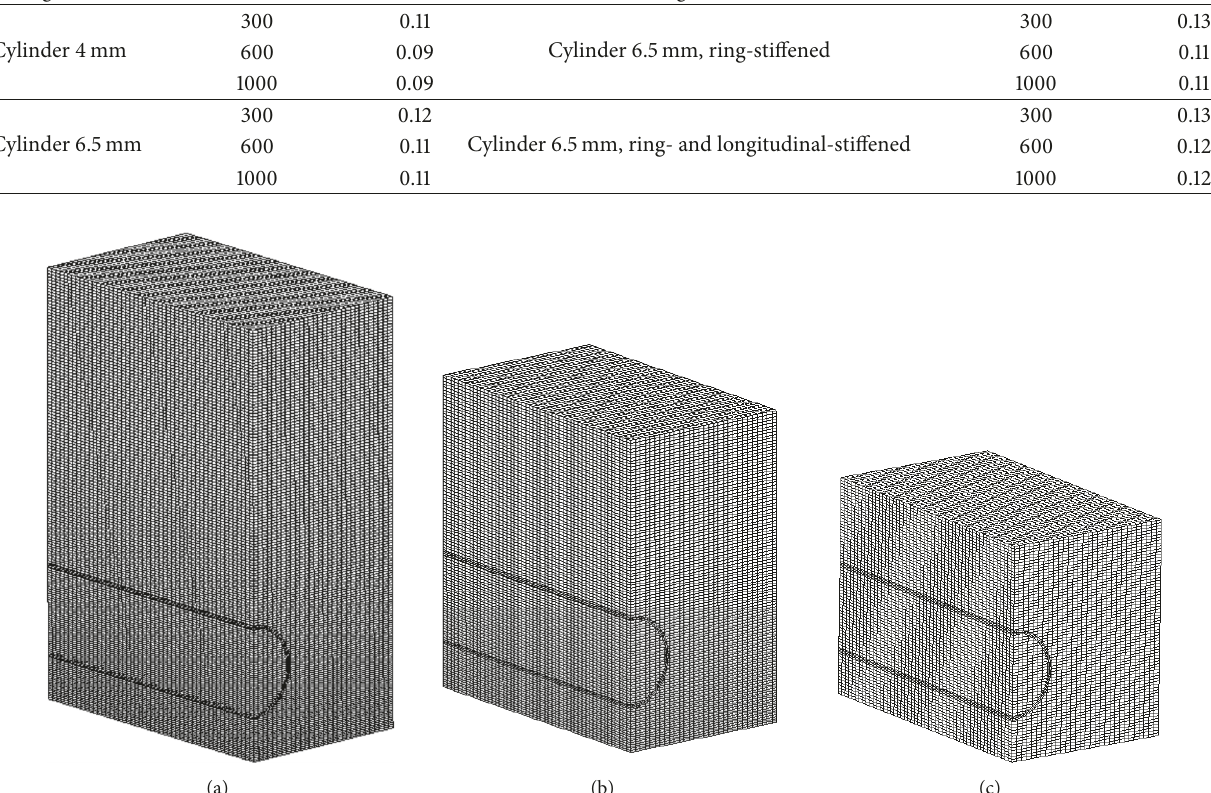
Figure 6: Eulerian grid for discretization of surrounding water medium: (a) far, (b) medium, and (c) near standoff explosion.